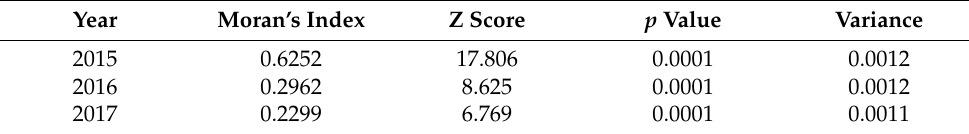
Table 3. Spatial autocorrelation results to identify the clustered spot.